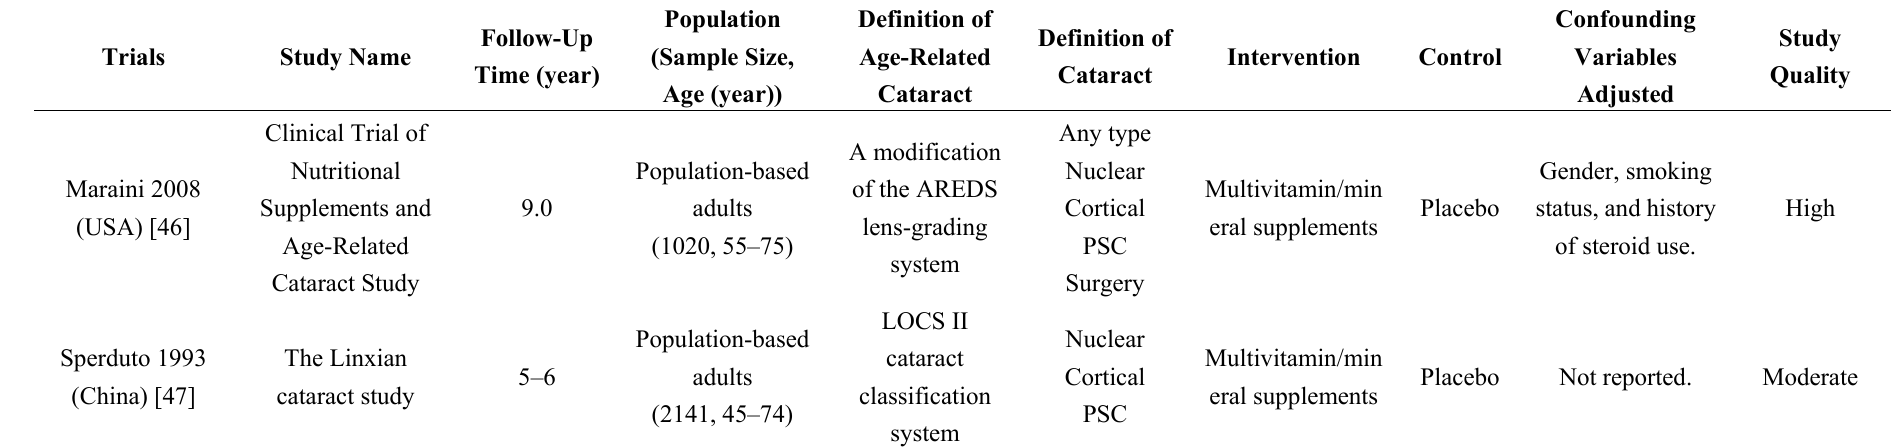
Table 2. Randomized controlled trials evaluating multivitamin/mineral supplementation and its association with the low risk of age-related